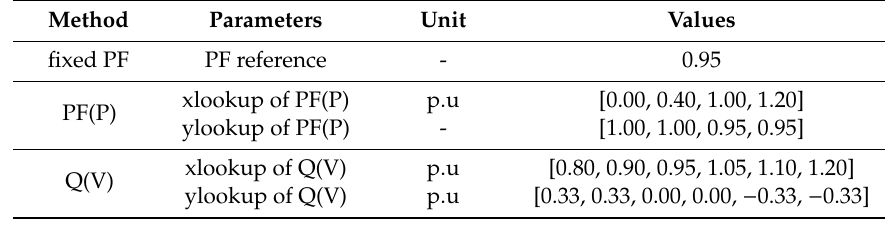
Table 2. Parameters of reactive power control methods.